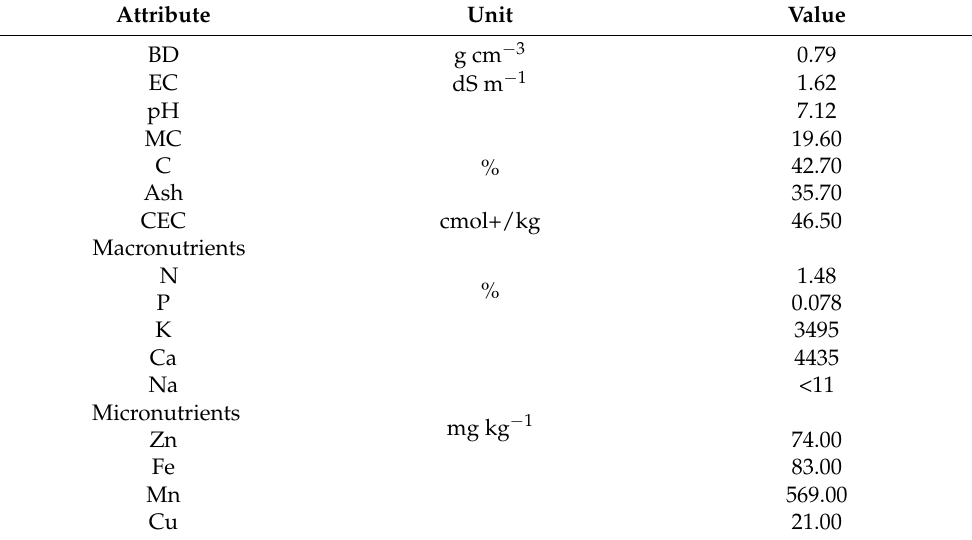
Table 2. Acidified biochar